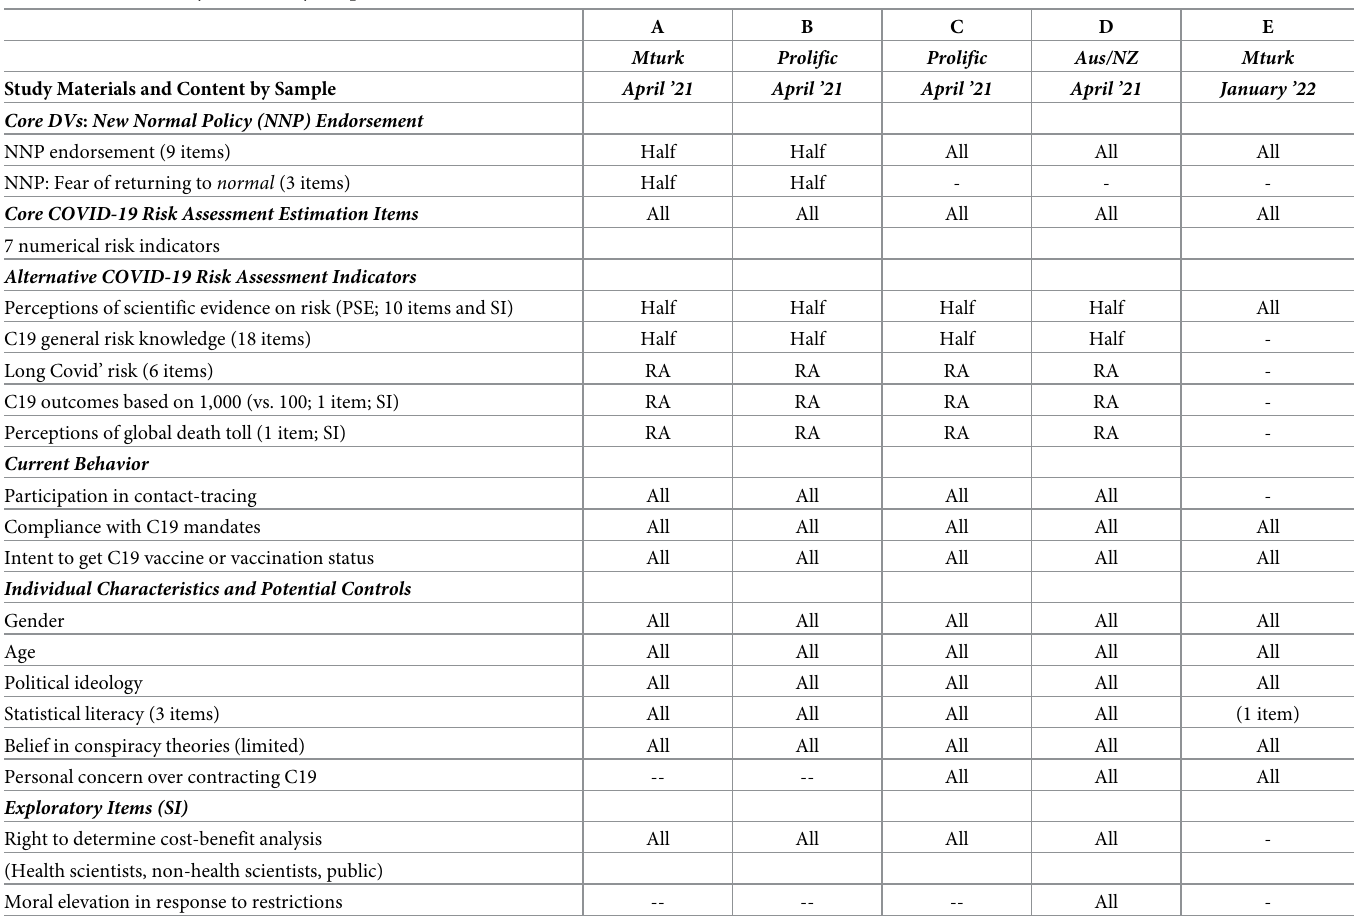
Table 2. Available study materials by